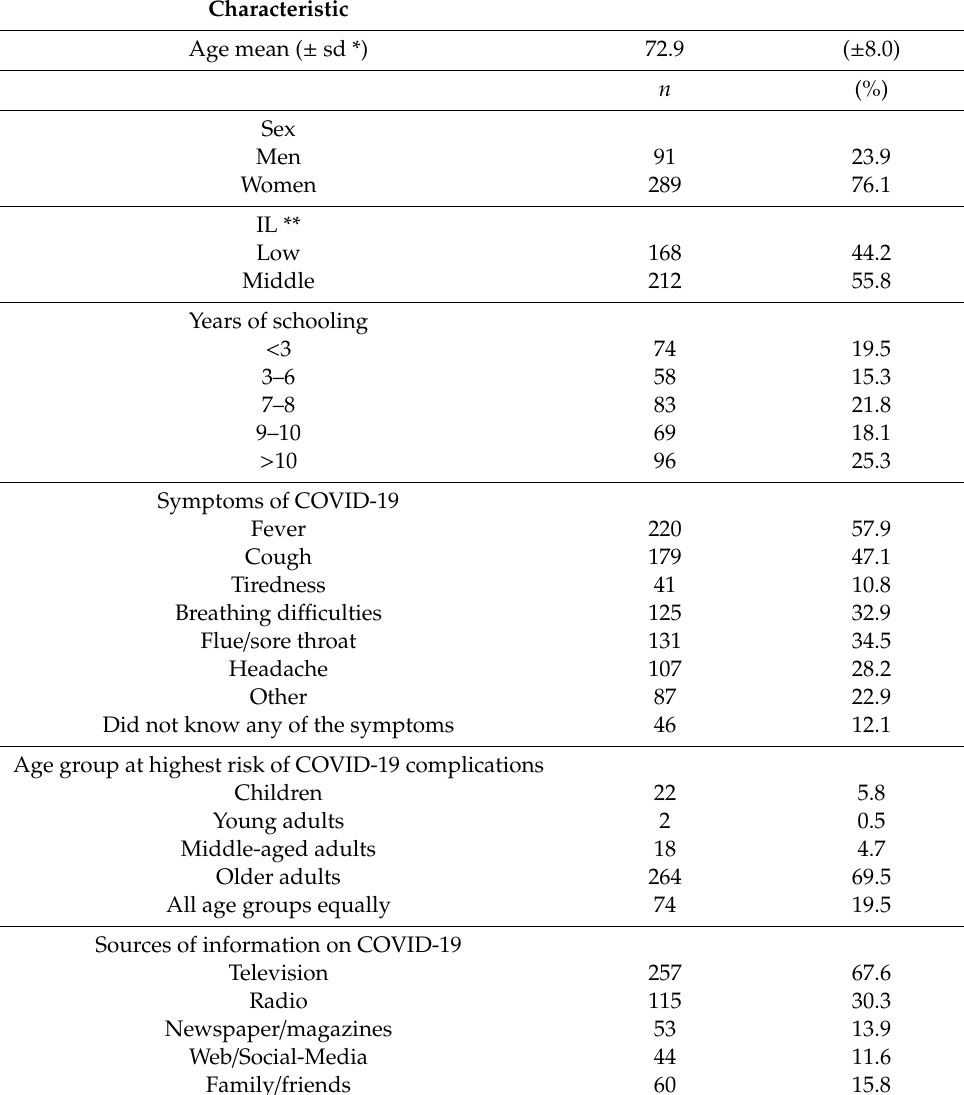
Table 2. Sociodemographic characteristics, knowledge, and sources of information on the coronavirus (COVID-19) pandemic in 380 adults ( ≥ 65 years old) in Mexico City. Number of respondents ( n ) and %